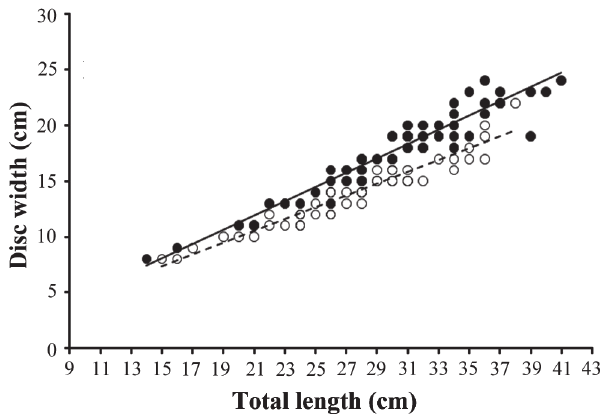
Fig. 6. Relationship between total length (TL) and disc width (DW) for Discopyge tschudii . Males (  ): DW(continuous line)= 0.638 X TL - 1.478; R 2 = 0.91; n= 71. Females ( o ):